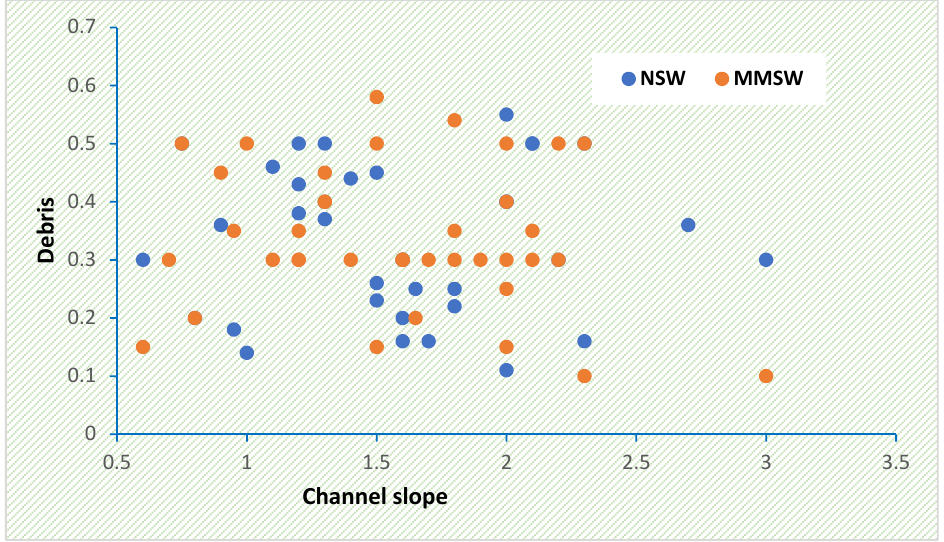
Figure 8. Correlation result of cross-drainage channel slope with man-made (MMSW) and natural solid wastes (debris) (NSW).